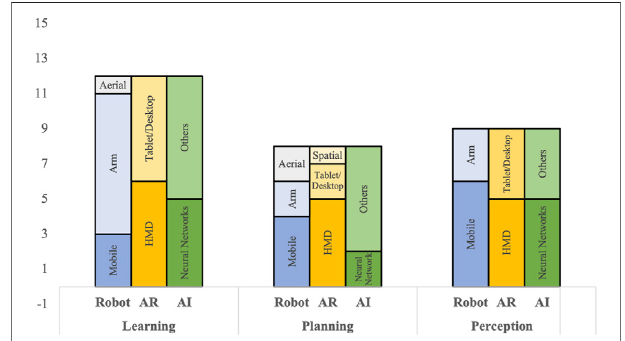
FIGURE5| Thequantitydistributionofthreefactors:Robotplatform,AR technology, and AI method, over the three robot applications: Learning, Planning, and